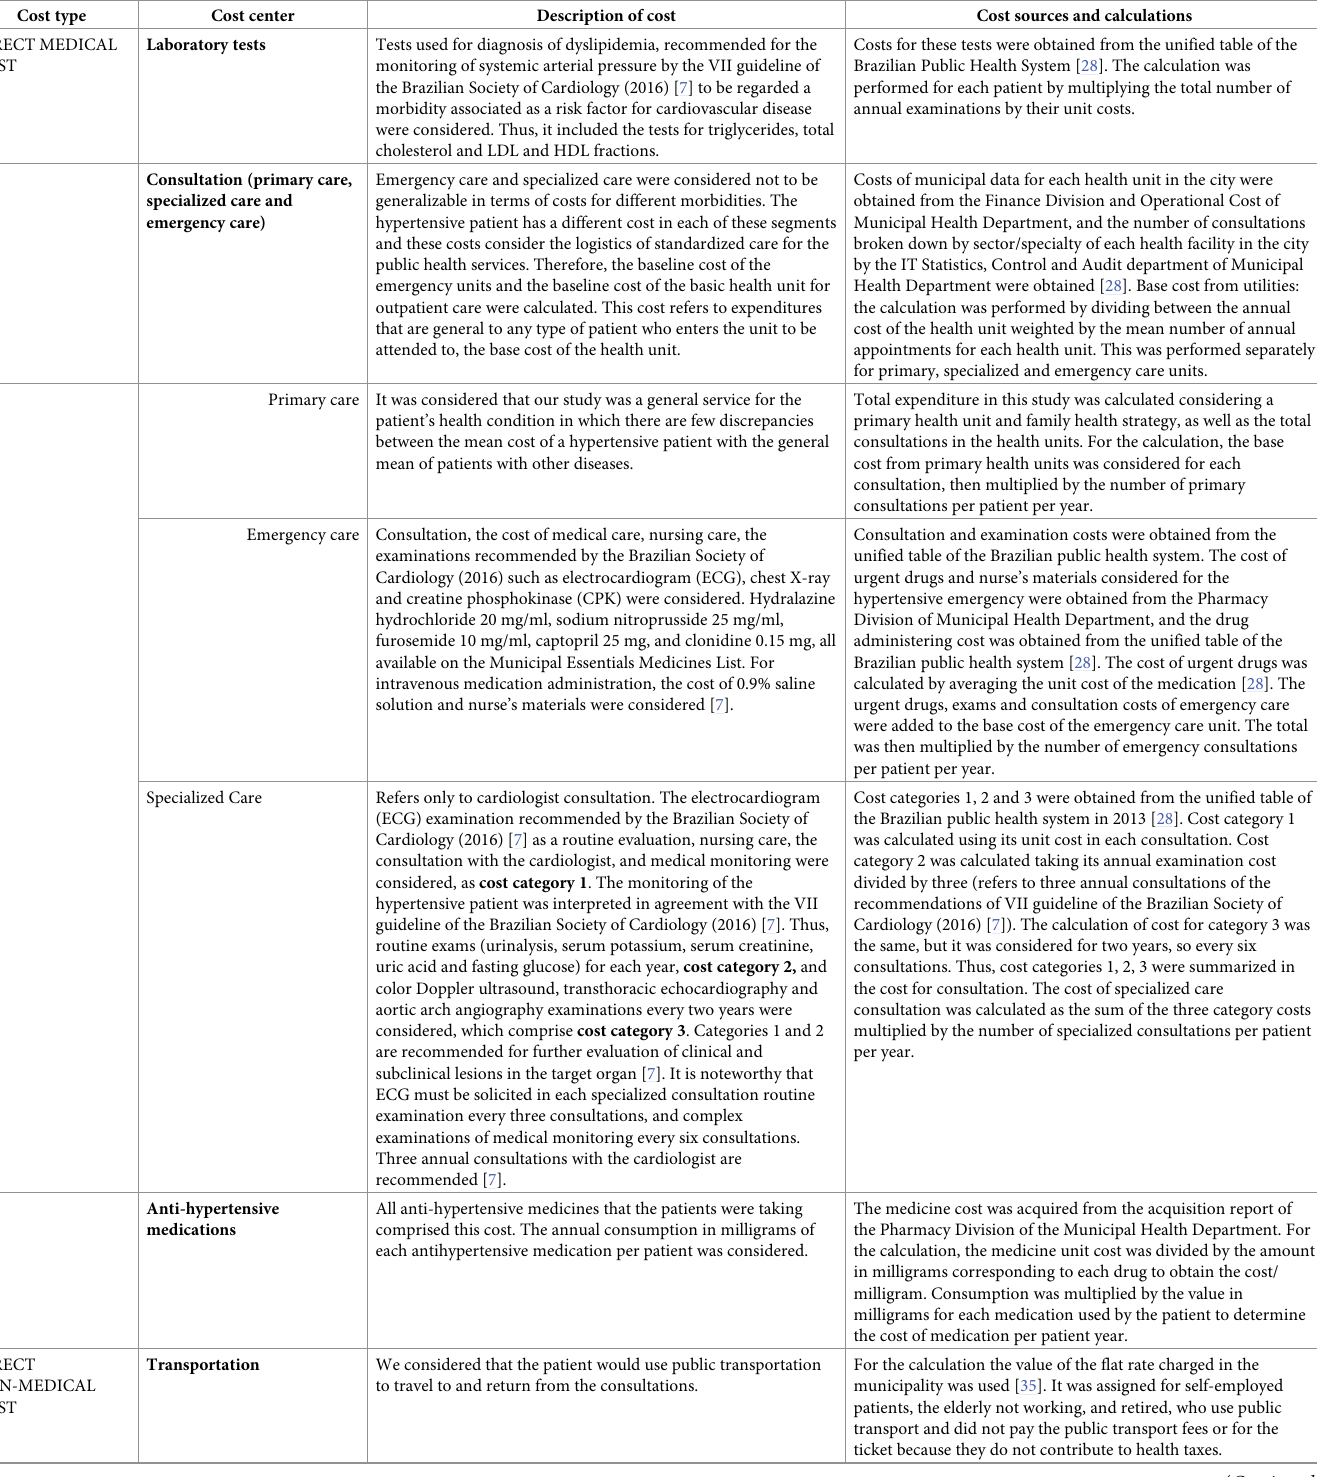
Table 1. Costing and description of direct